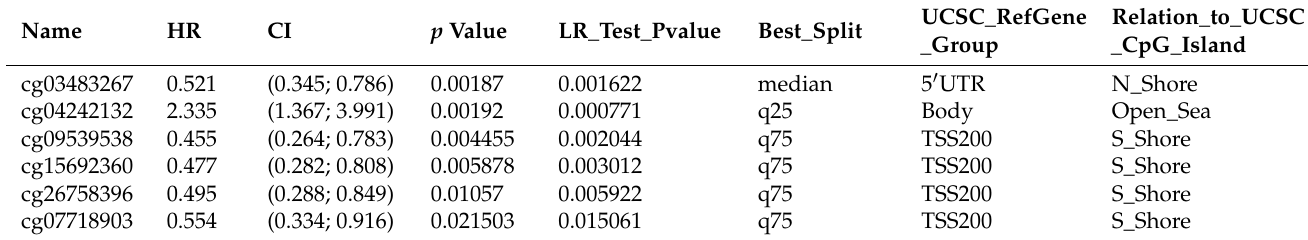
Table 2. The prognostic value of CpG in